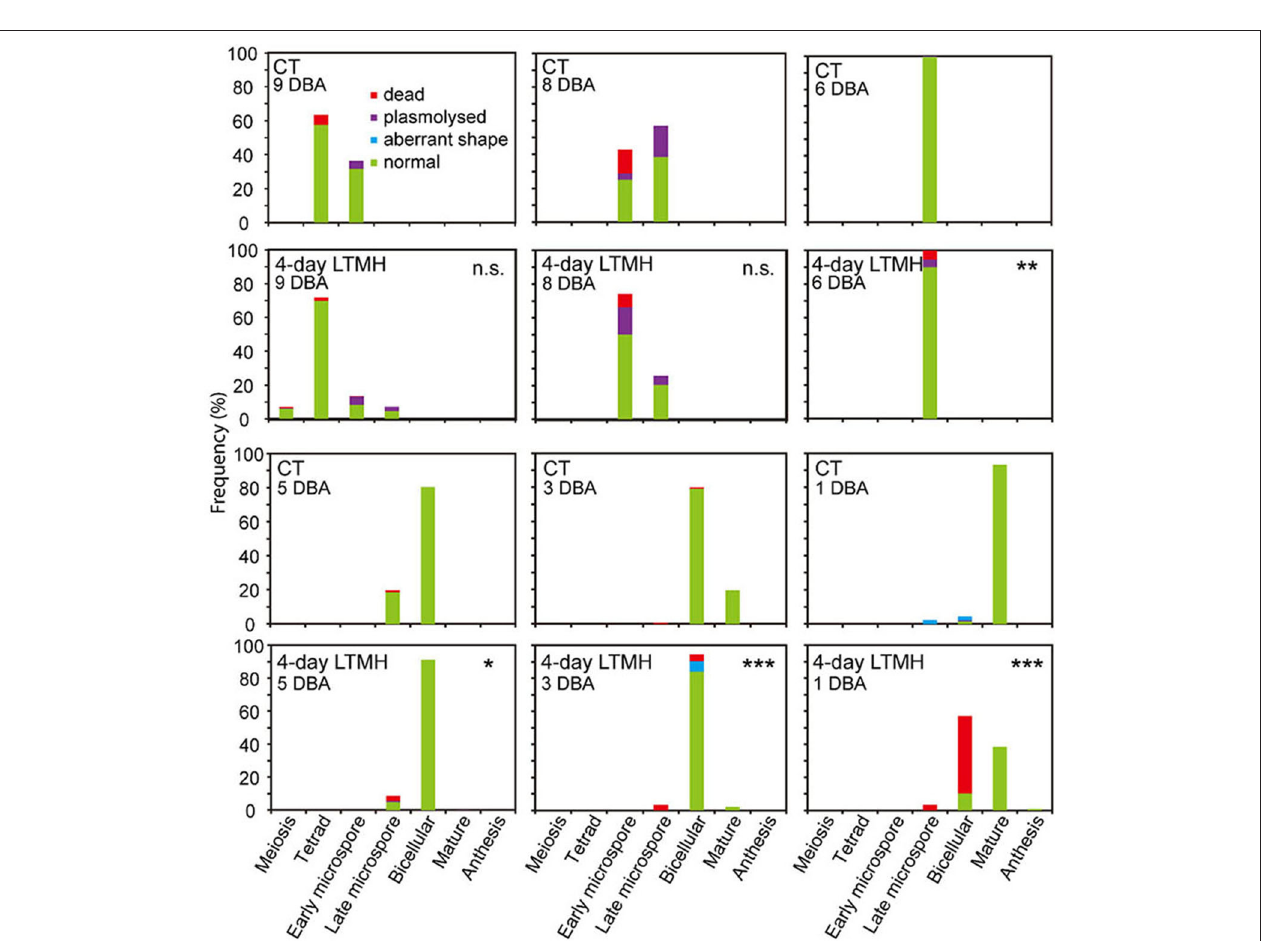
FIGURE 2 | Frequency analysis of pollen development in anthers from control and 4-day long-term mild heat treatment. Long-term mild heat (LTMH) or control temperature (CT) were applied for 4 days, and flowers that were at the 10-DBA stage on the last day of the treatment (i.e., they were treated from 13 DBA to 10 DBA) were labeled and then sampled on subsequent days (at stages of 9, 8, 6, 5, 3, and 1 DBA) for cytological analysis of pollen development (see Supplementary Table S1 ). For each flower stage per treatment, 100 to 140 locules were analyzed. Developing pollen were assigned to four categories: normal, aberrant shape, plasmolysed, or dead. *, Student’s t -test, total percentage of normal, living pollen in LTMH treatment significantly less than in CT treatment on the same day P < 0.05; ** P < 0.01; *** P < 0.001; n.s., not